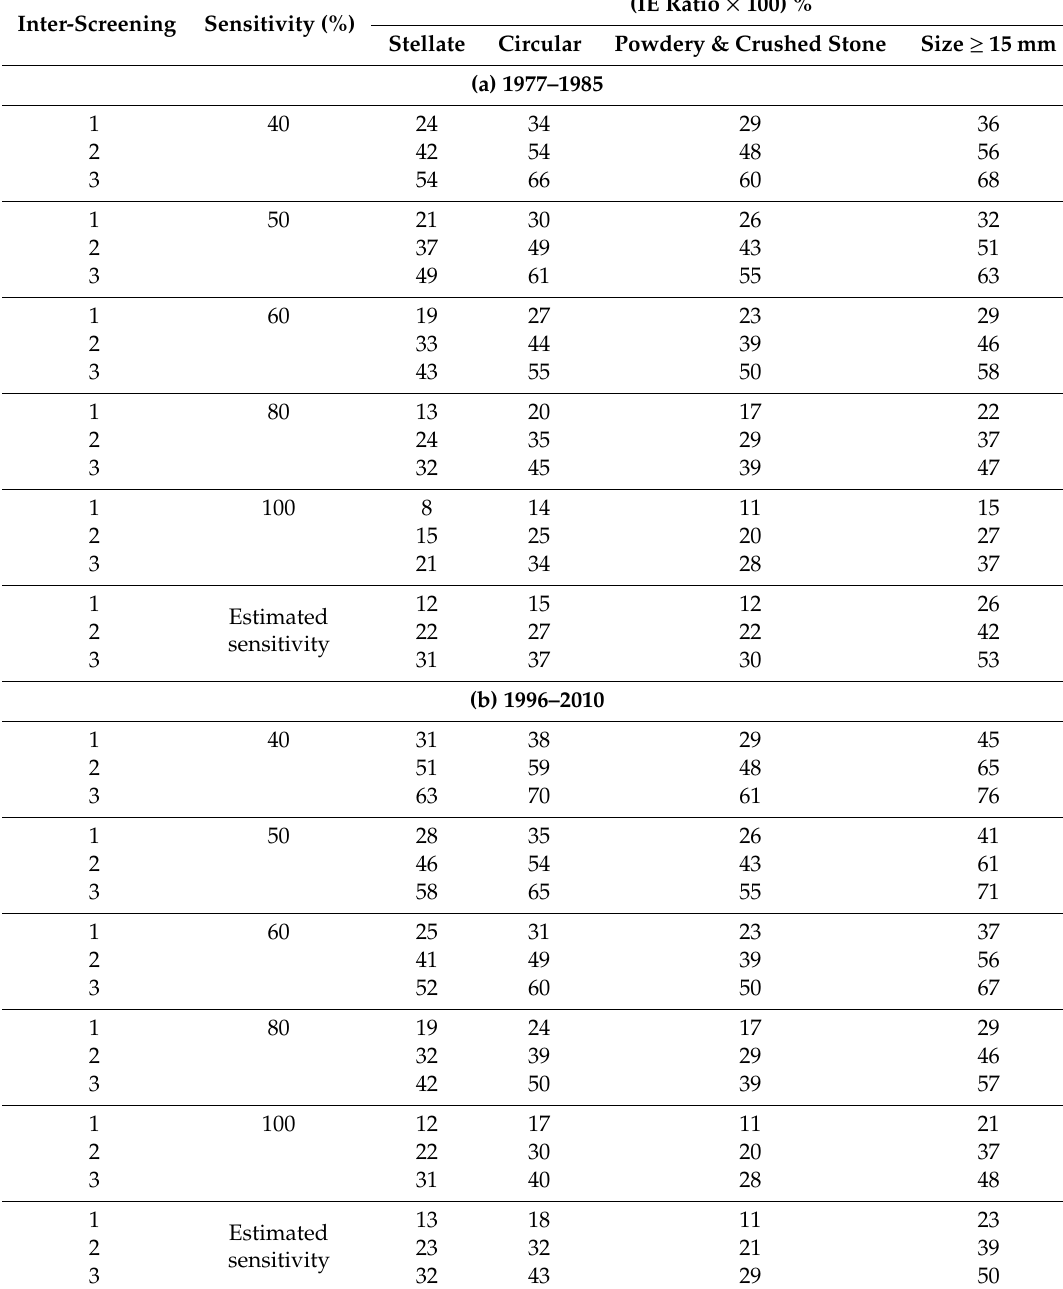
Table 1. Simulated results with respect to proportional interval cancer incidence for breast cancer varying with inter-screening interval and